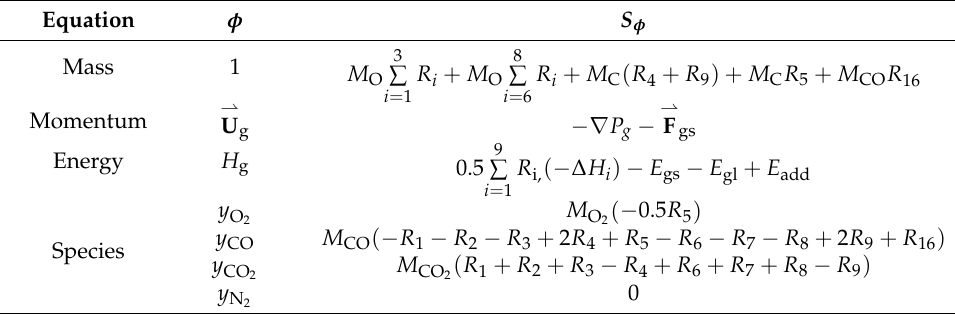
Table 4. Dependent variables and sources in Equation